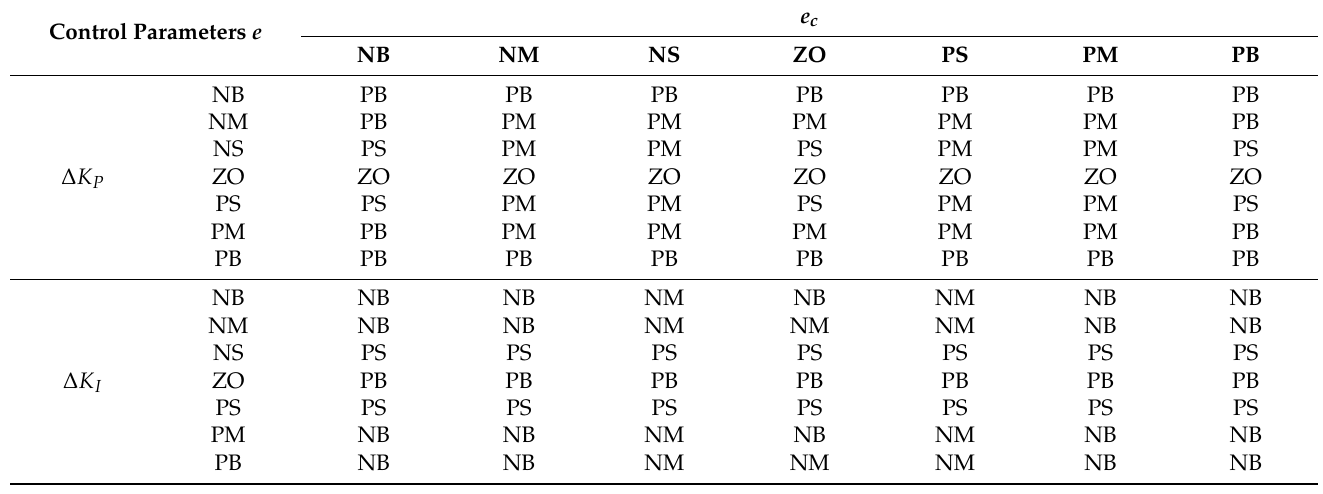
Table 1. Fuzzy control table for ∆ K P and ∆ K I .